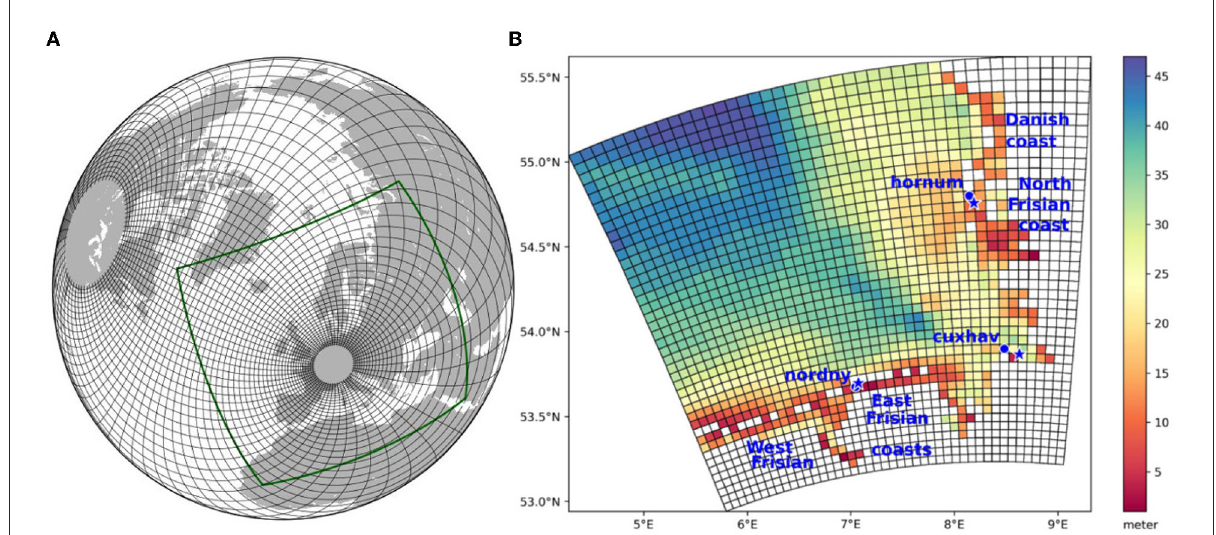
FIGURE1 (A) Grid of downscaling coupled MPIOM-REMO model system. Grid lines display the grid of MPIOM. Green lines mark the EURO-CORDEX22 region of REMO, which is coupled with MPIOM. (B) Zoom of the MPIOM grid into the German Bight with grid lines and bathymetry (m) to visualize the fine horizontal resolution of MPIOM in this area. Time series at locations of Norderney (“nordny”), Cuxhaven (“cuxhav”), and Hörnum (“hornum”) will be presented in this study as representatives for the southern, central, and eastern/northern German Bight coasts. Their real positions are marked with stars, their model positions with filled